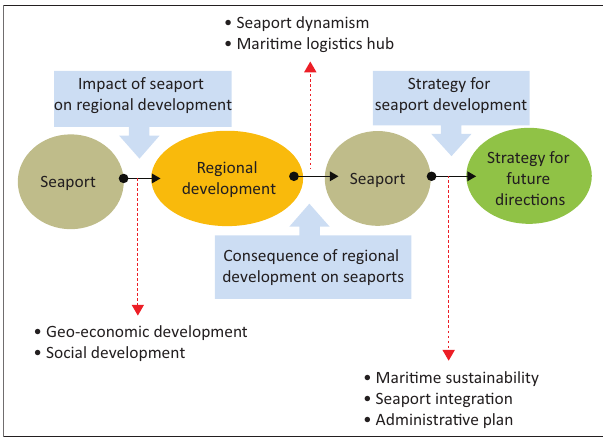
FIGURE 2: Summary of the